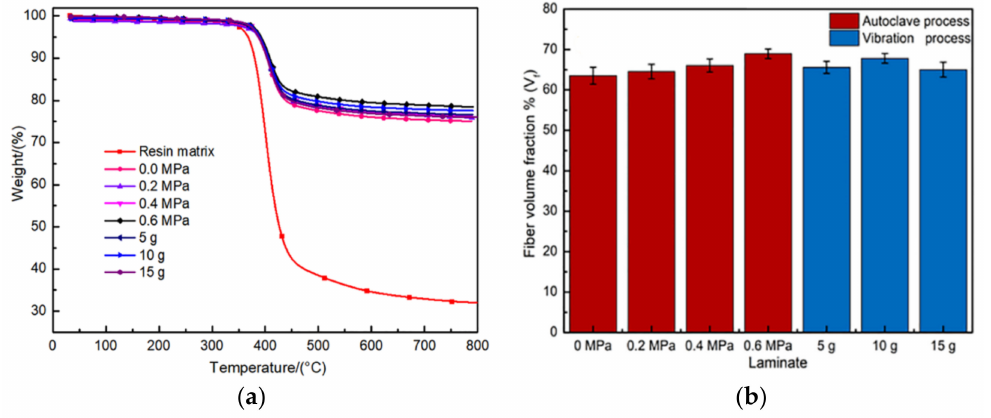
Figure 11. ( a ) The typical TGA response of resin and composite samples, ( b ) fiber volume fraction of the composite